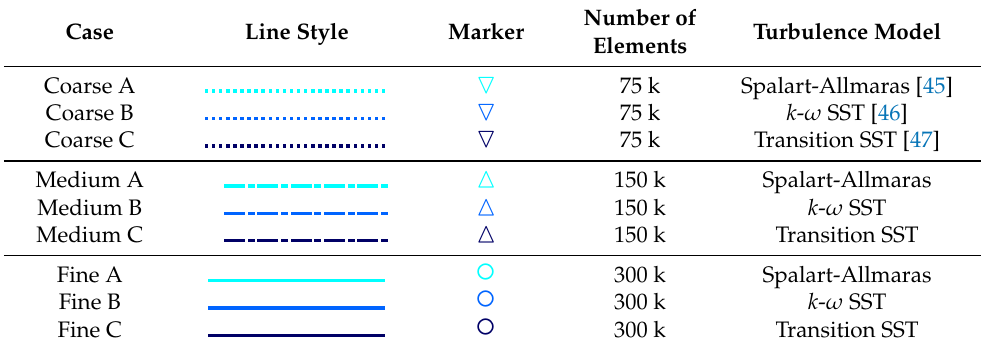
Table 1. Models parameters resume and line